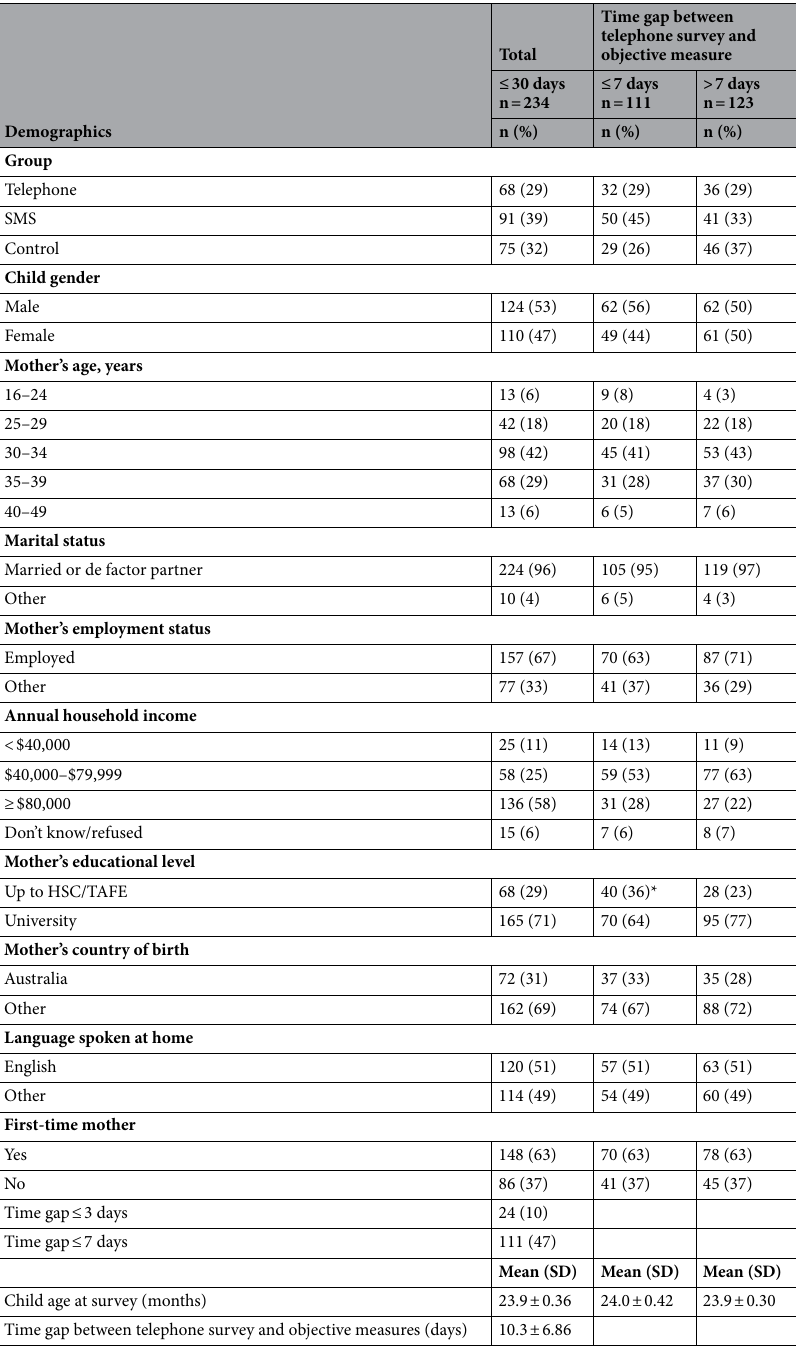
Table 1. Characteristics of the study participants who were part of HB CHAT study in Sydney 2017–2019. The sums of the variables are not the same due to missing values. * P <